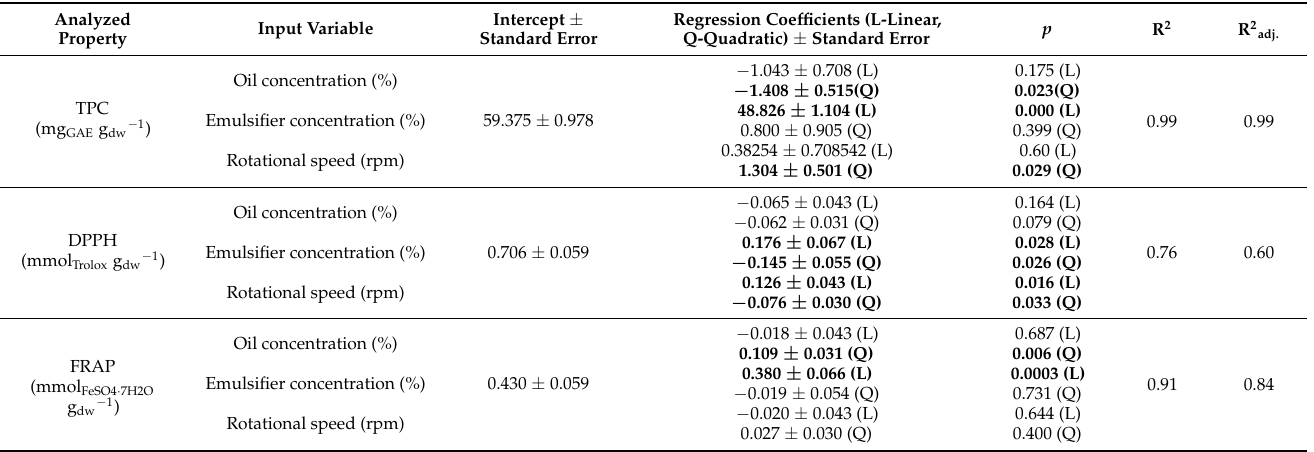
Table 4. Response surface models regression coefficients and determination coefficients for chemical properties of oil-in-water emulsions containing oregano extract with the addition of commercial pea protein as emulsifier (bold values: p <